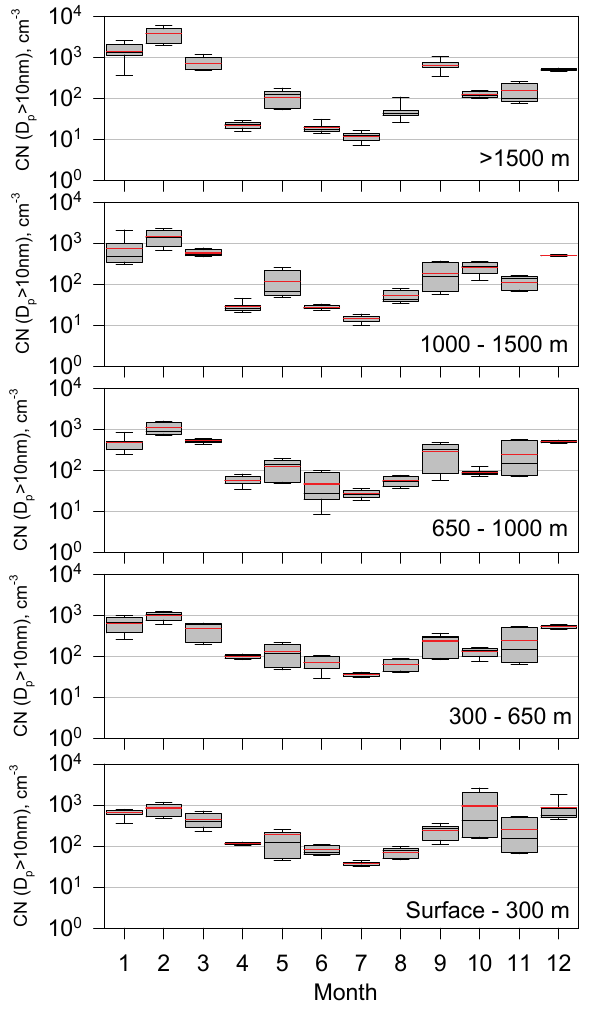
Fig. 4. Seasonal variation of CN concentration in each altitude. Top and bottom of the bar in box plots indicate 95 and 5% values. Top, middle and bottom of the box indicate 75, 50 (median), and 25% values. Red lines indicate monthly mean CN